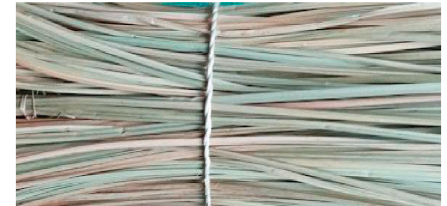
Figure 1: Nonwoody CDA